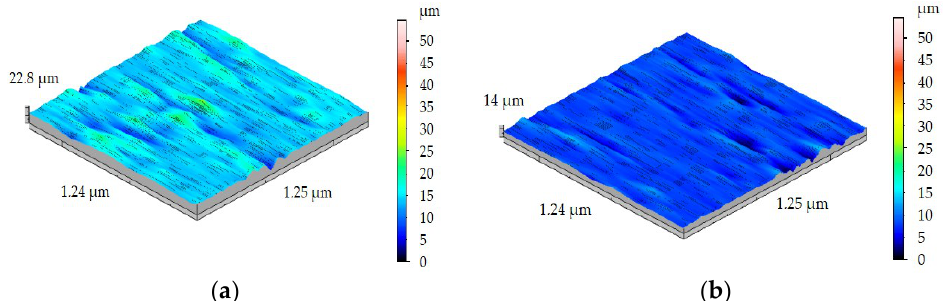
Figure 13. Results of 3D surface measurement samples after turning with f = 0.05 mm/rev of ( a ) FEPA 046, ( b ) FEPA 100.